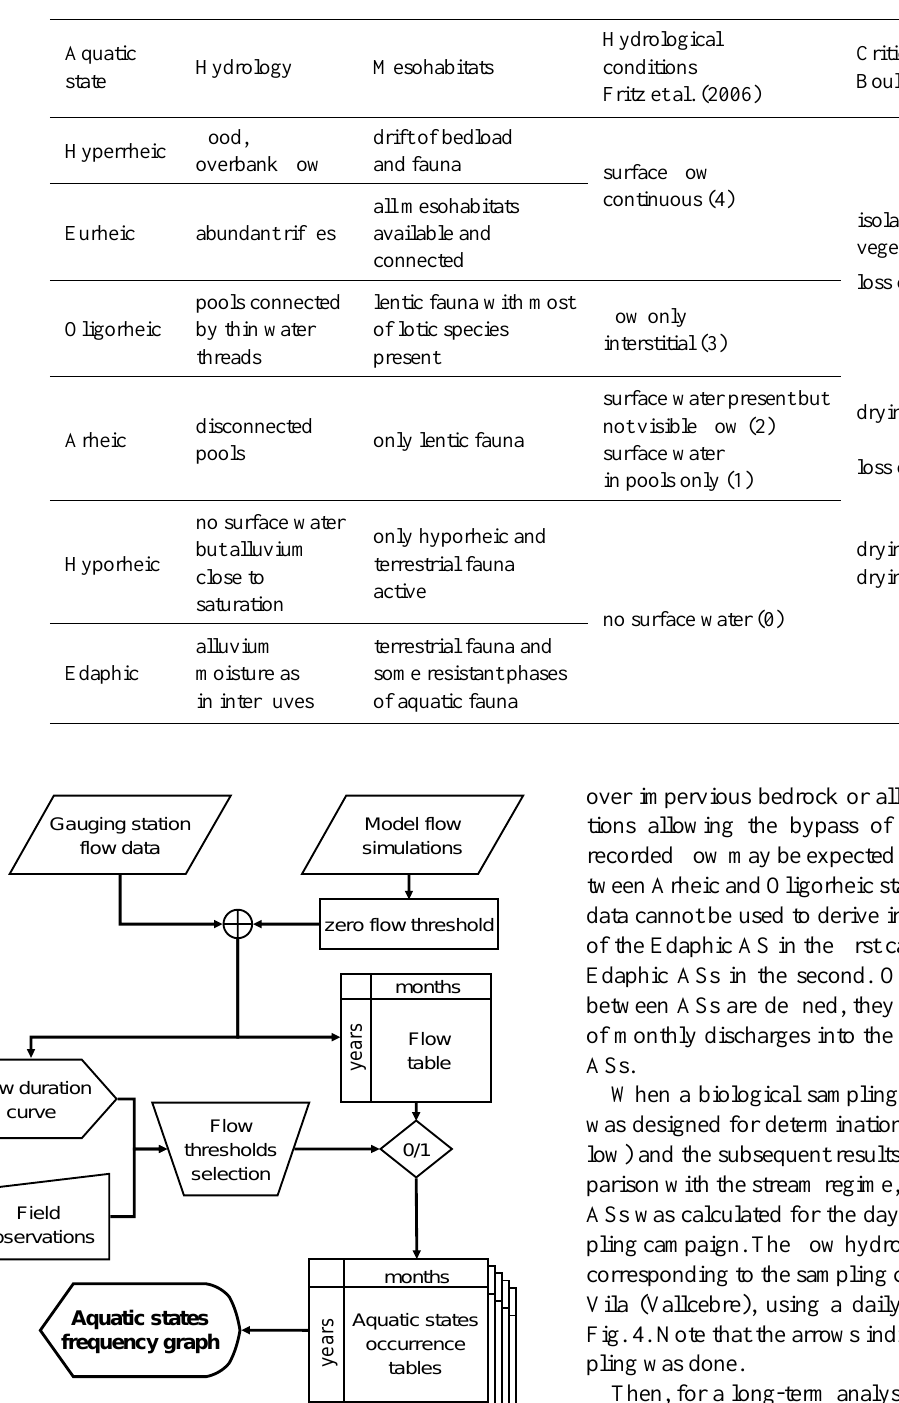
Table 2. Characterisation of the aquatic states in terms of hydrological and ecological features and comparison with two former schemes.